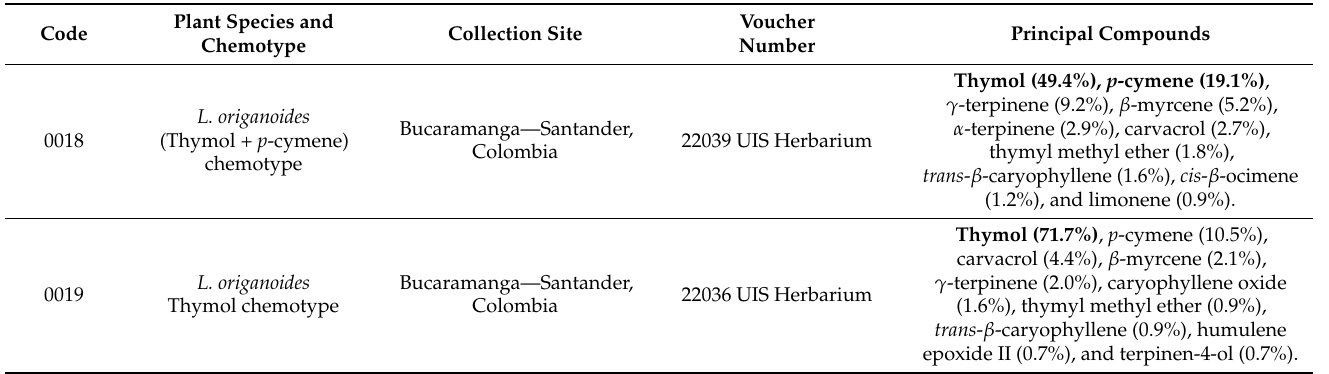
Candida spp. strains and clinical isolates displayed different antifungal susceptibility